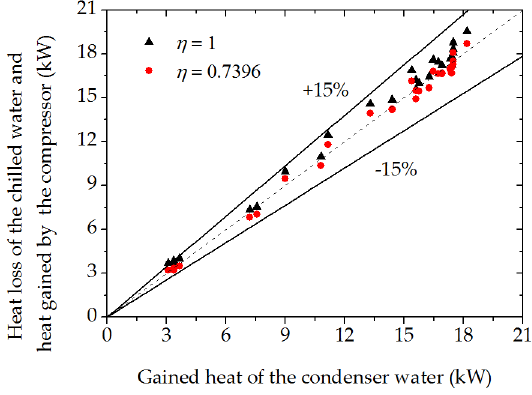
Figure 4. Energy balance of the HP unit test.